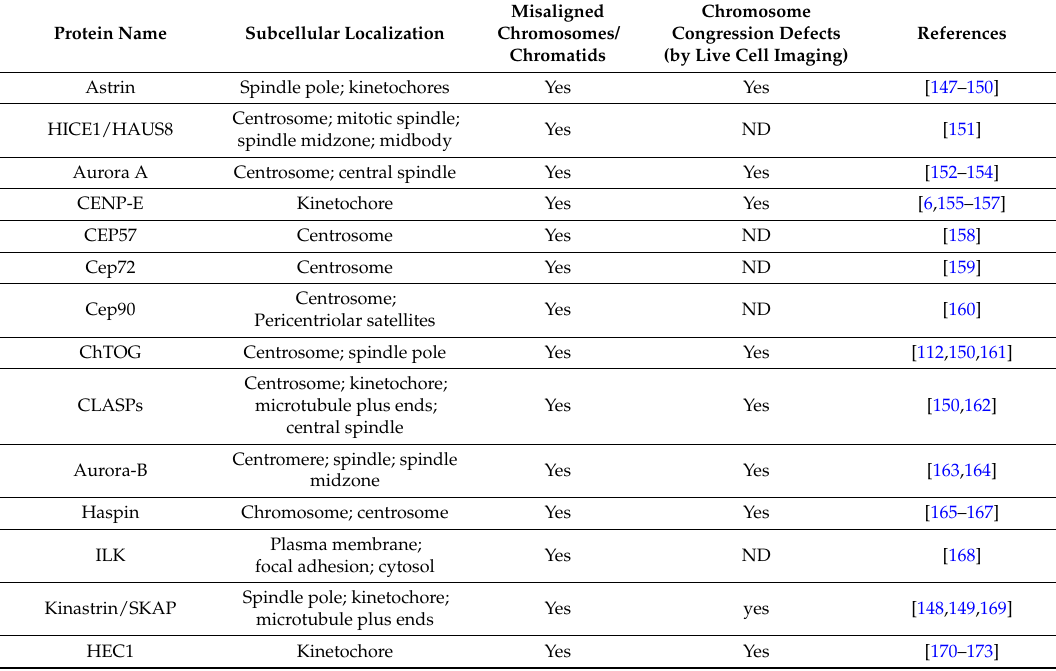
Table 1. Proteins that have been implicated in chromosome